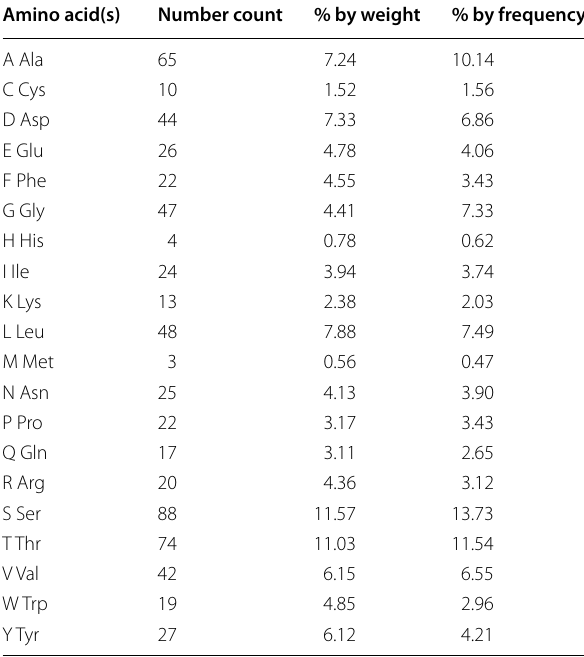
Table 3 The amino acid composition of